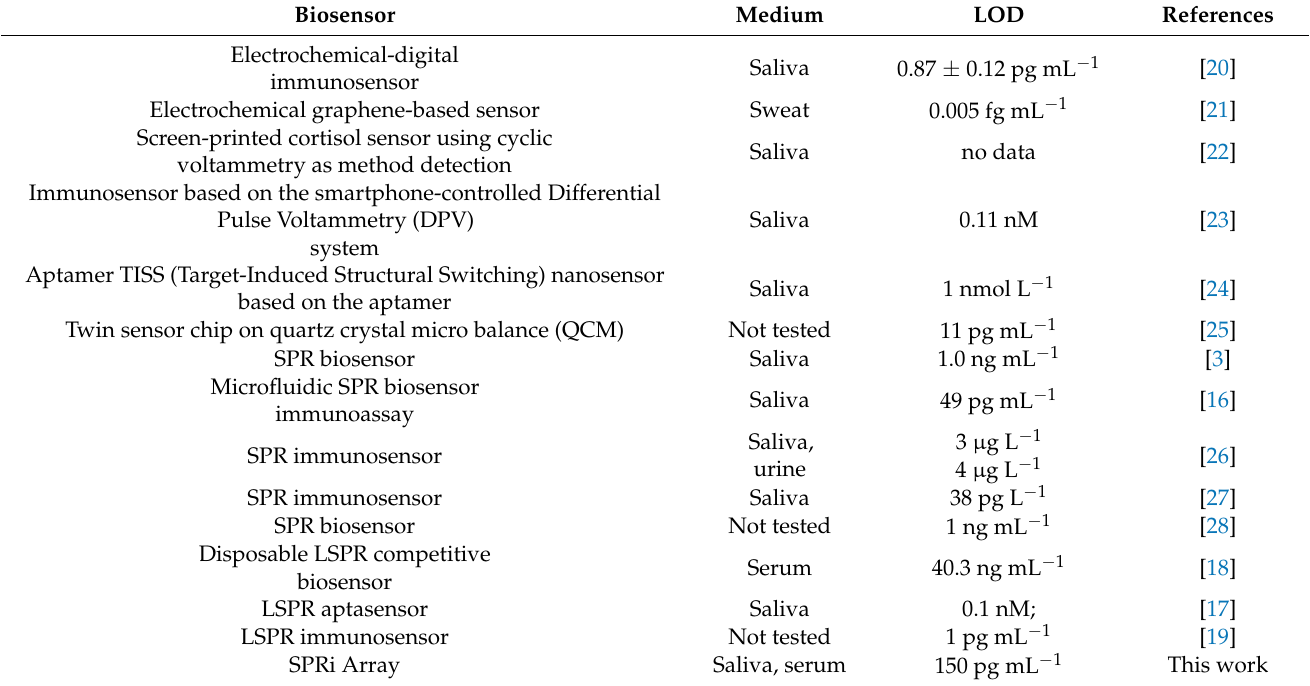
Table 1. Biosensors used for cortisol